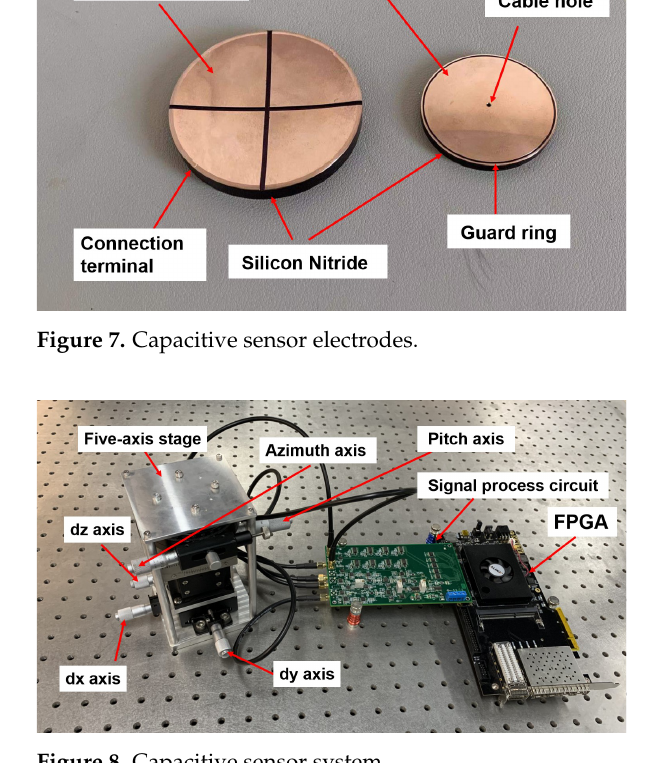
Figure 8. Capacitive sensor system.